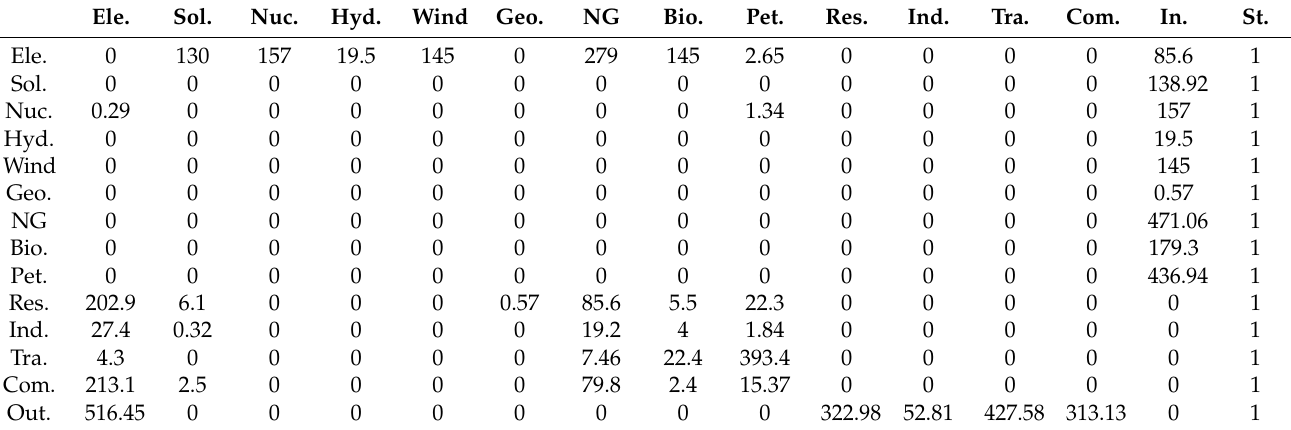
Table 4. Direct flow matrix for Maryland’s simulated RPS for year 2030. Ele = electricity; sol =